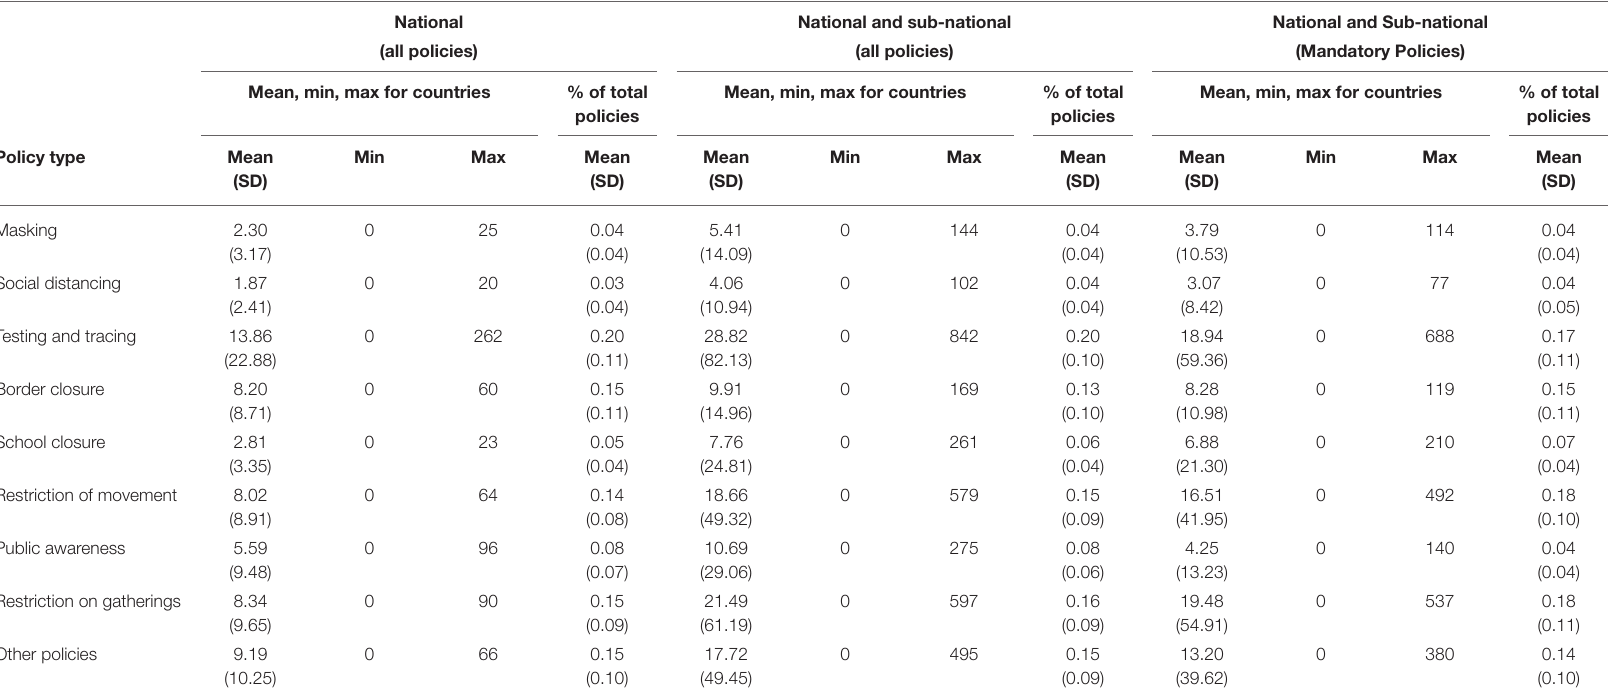
TABLE 2 | Summary statistics for count of policies categorized by government level, mandatory and non-mandatory. National National and sub-national National and Sub-national (all policies) (all policies) (Mandatory Policies) Mean, min, max for countries % of total Mean, min, max for countries % of total Mean, min, max for countries % of total policies policies